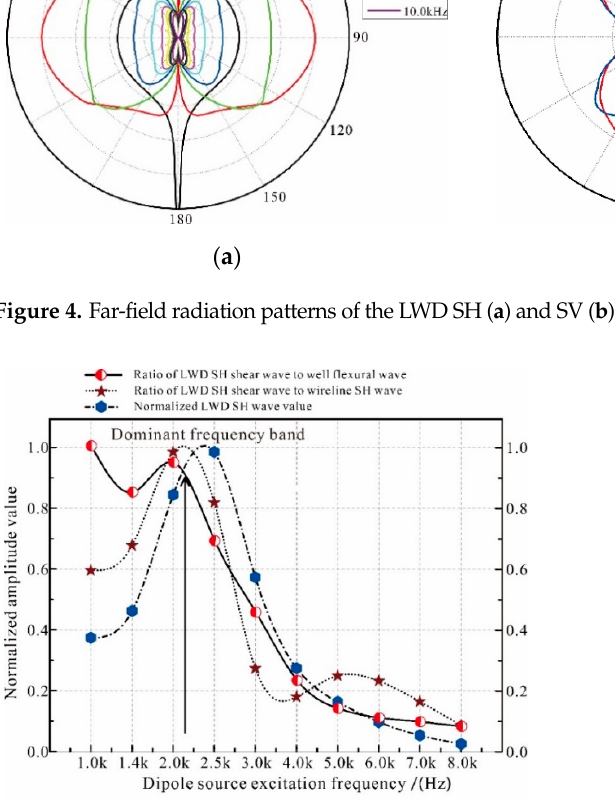
Figure 5. Relationships between source frequencies and LWD SH wave normalized